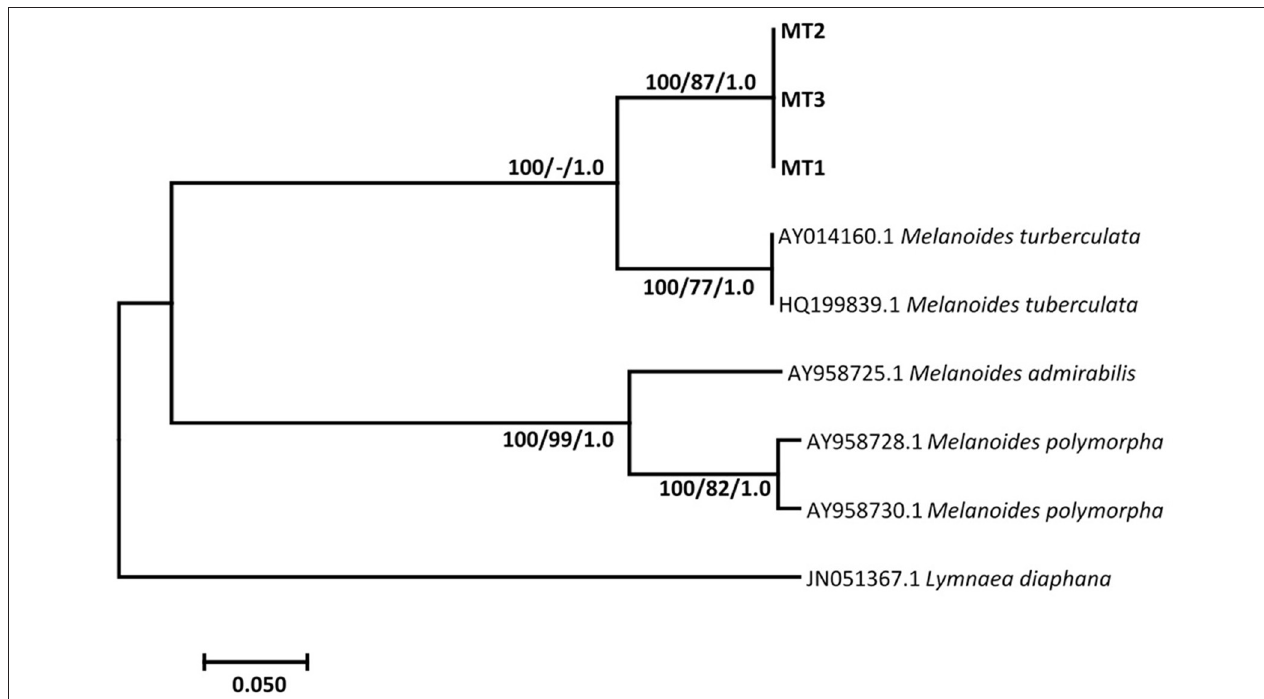
FIGURE 1 | Neighbor-joining tree based on the 399-nucleotide sequence of the ITS-2, confirming the identity of Melanoides sp. (MT1-3) (in bold) collected from Mpumalanga province of South Africa and their relationship with other Melanoides species obtained from the NCBI GenBank database. The support value indicated on the nodes follows the order neighbor-joining bootstrap value/maximum likelihood bootstrap value/Bayesian inference posterior